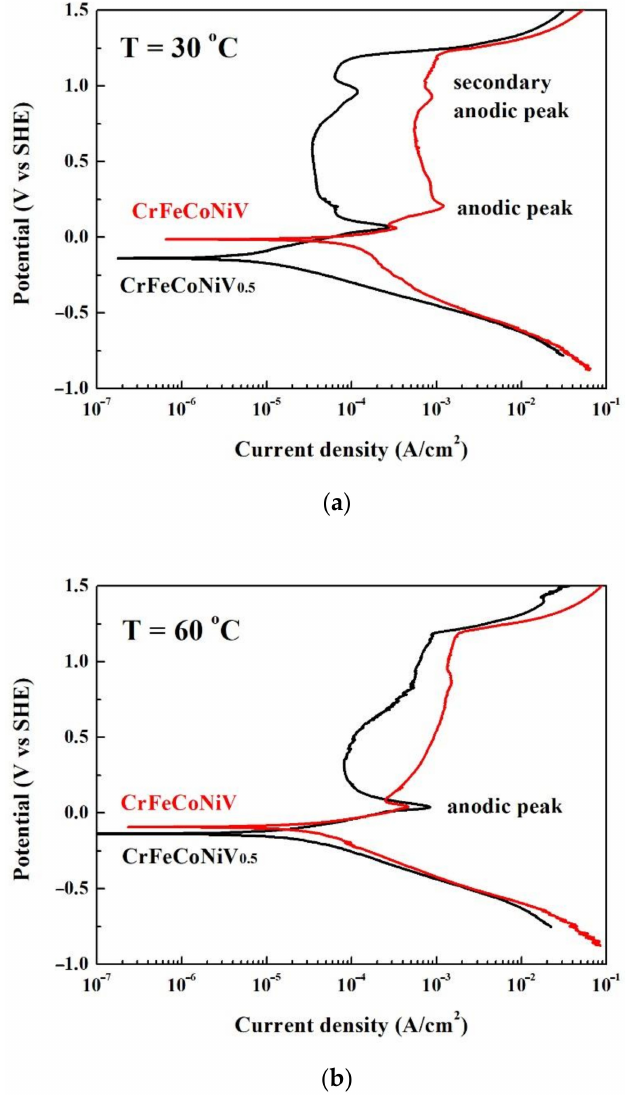
Figure 6. The potentiodynamic polarization curves of as-cast CrFeCoNiV x alloys tested in 1M deaerated HCl solution at different temperatures: ( a ) 30 ◦ C and ( b ) 60 ◦